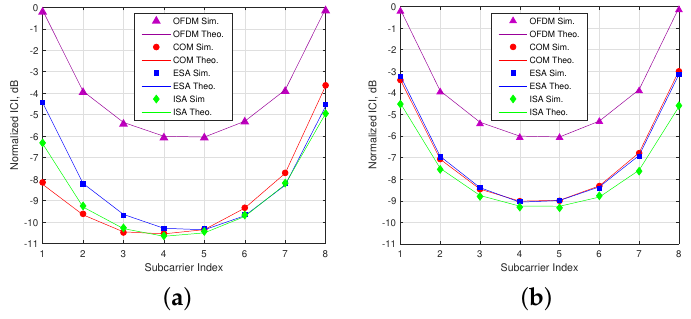
Figure 8. ICI analysis for OFDM and OFDM-IM regarding to three SMS-s. ( a ) SMS-s with s = 8 and v = 3. ( b ) SMS-s with s = 8 and v = 4.